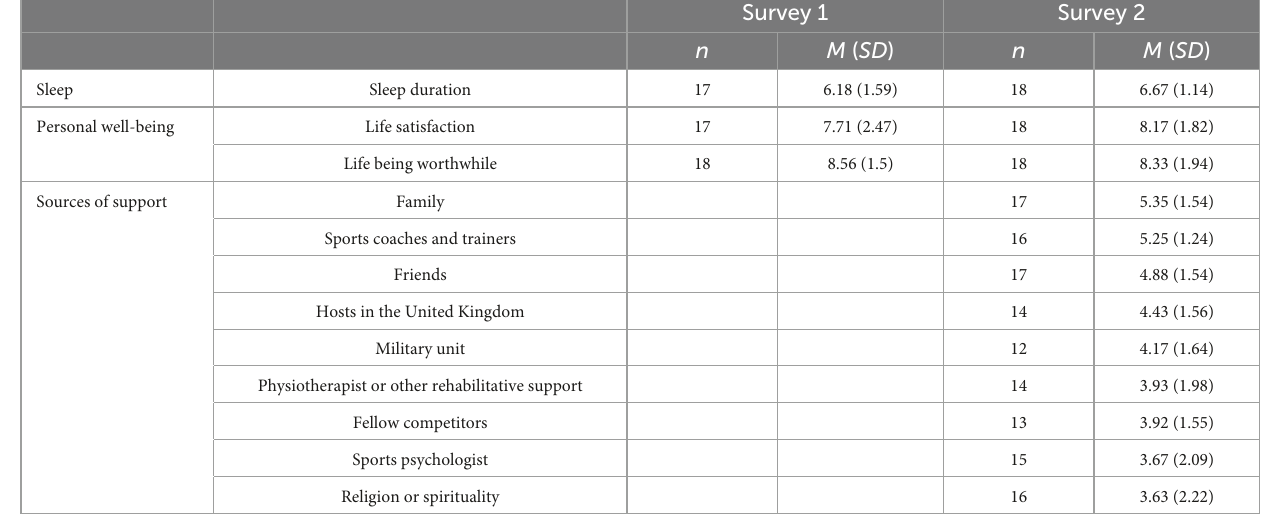
TABLE 3 Sleep, personal well-being, and sources of support in Survey 1 and Survey 2.